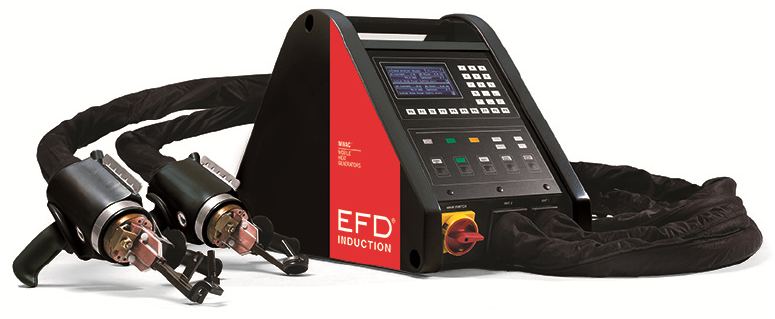
Figure 16. EFD Induction mobile induction heating equipment Miniac